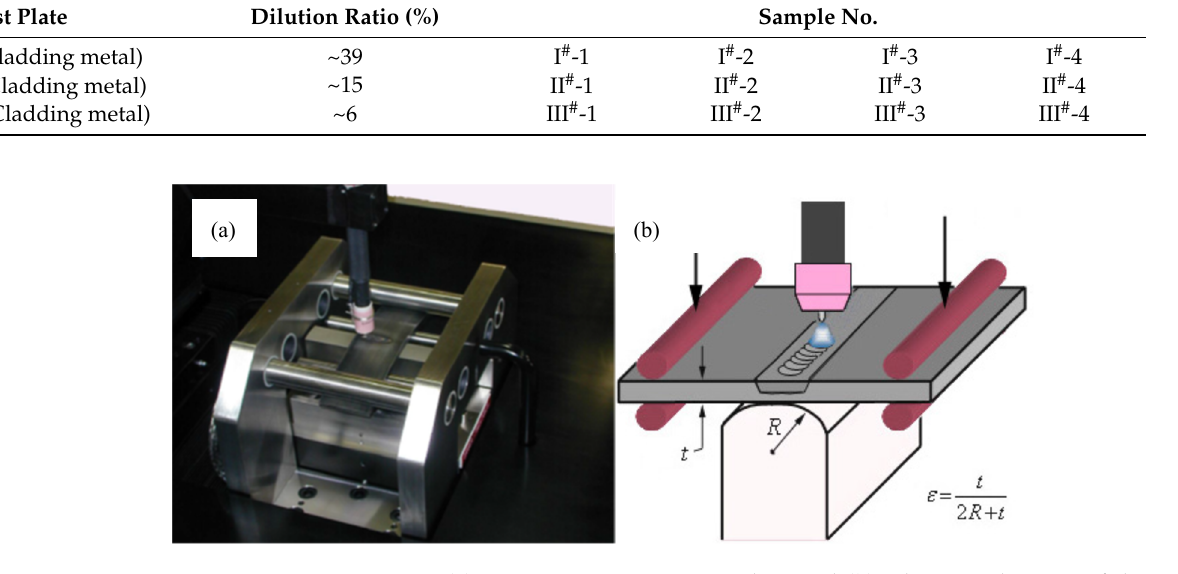
Figure 2. Varestraint test: ( a ) equipment Varestraint tooling and ( b ) schematic diagram of the test process.